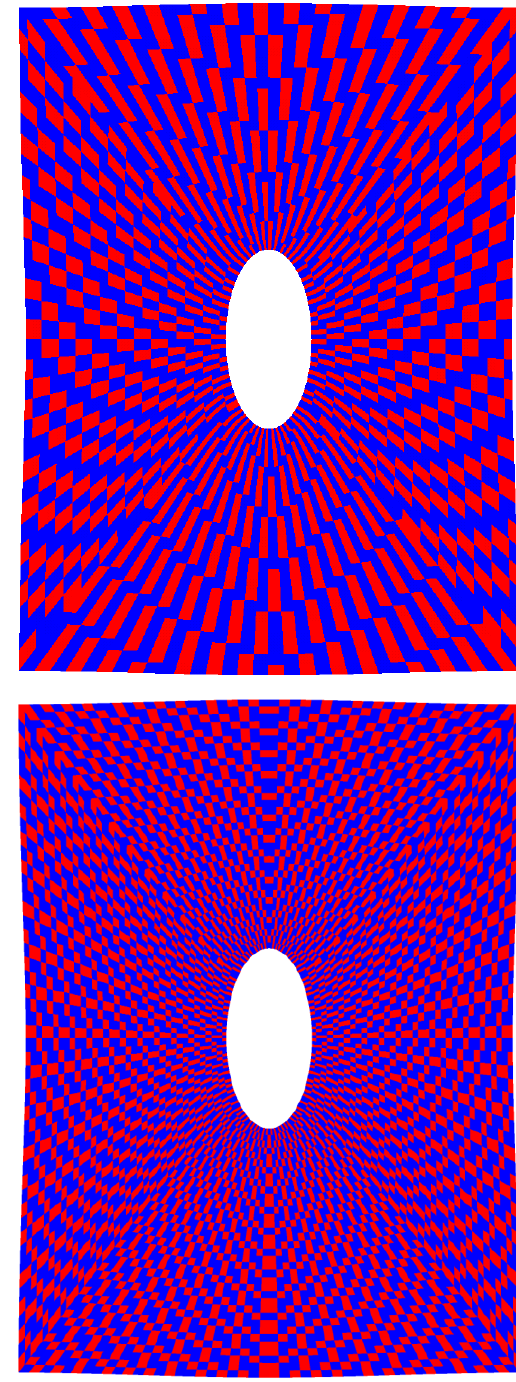
Figure 7. Coarse ( top ) and fine ( bottom ) meshes in undeformed ( left ) and deformed ( right ) config-